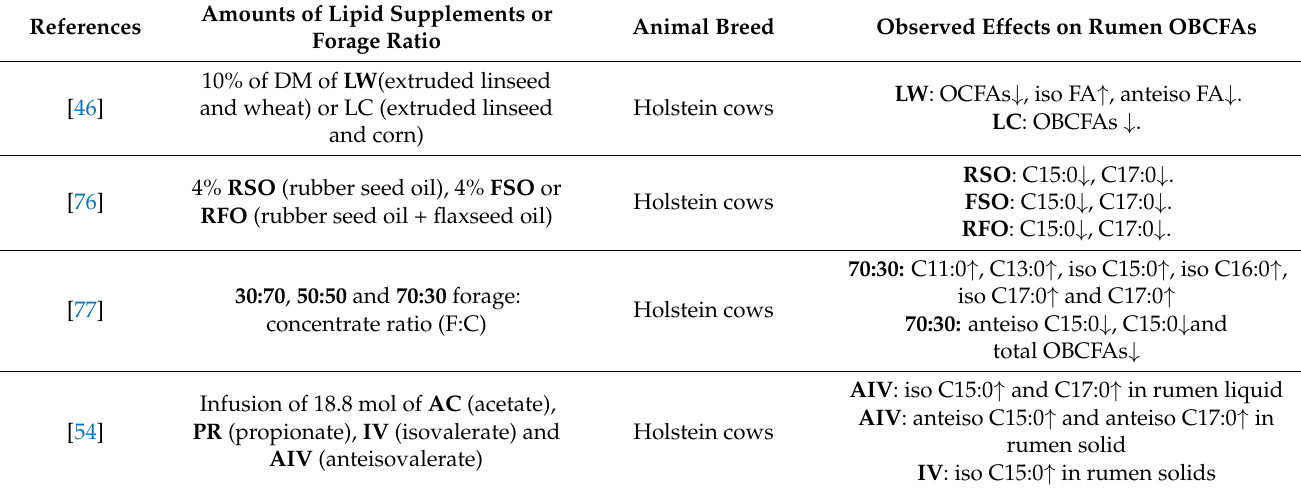
Table 1. Summary of the effects of lipid supplements and forage proportions on OBCFAs synthesis in the rumen of dairy cows.